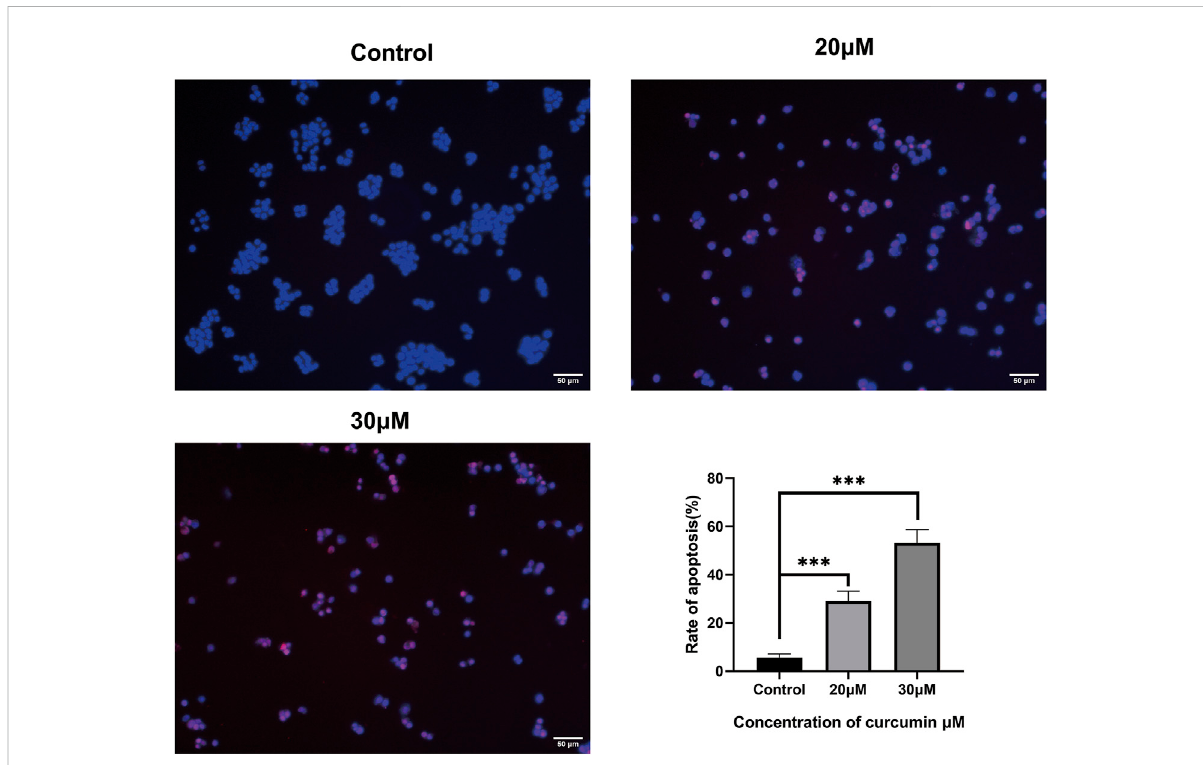
FIGURE 7 Evaluation of cell apoptosis by TUNEL assay. The SK-MEL-1 cells were treated with curcumin in concentrations of 0, 20, and 30 μ M. Cell apoptosis was signi fi cantly promoted in curcumin-treated groups in comparison to that of the control group. TUNEL-positive cells were stained in red color, and the nucleus stained by DAPI was in blue. *p < 0.05 and ****p < 0.0001, one-way ANOVA.